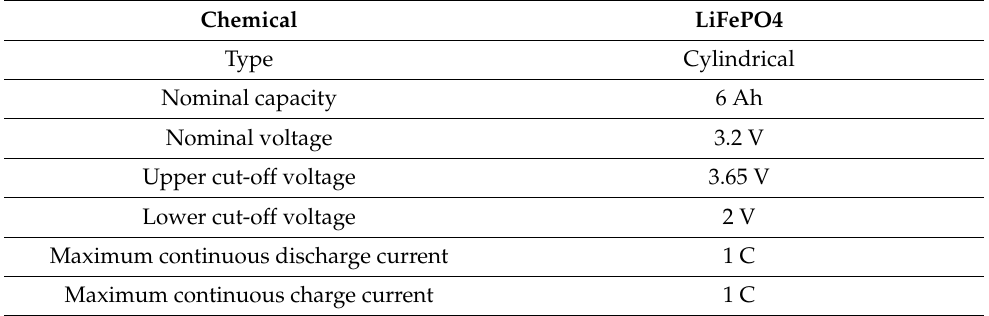
Table 2. Battery cell